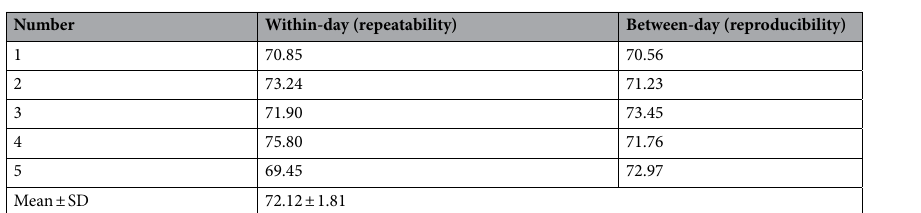
Figure 10. ( a ) UV–Vis spectra of MG dye solution before and after adsorption (adsorbent mass = 8 mg, V = 50 mL, T = 25 °C, pH 8.0, and contact time = 15 min), ( b ) the R% of regenerated adsorbent irradiated at various MW powers, ( c ) the temperature profiles of the sample measured by the thermocouple at different MW powers, and ( d ) the R% of MG dye onto meso-CaAl 2 O 4 at different cycles (error bars presents ± standard deviations, n = 3).